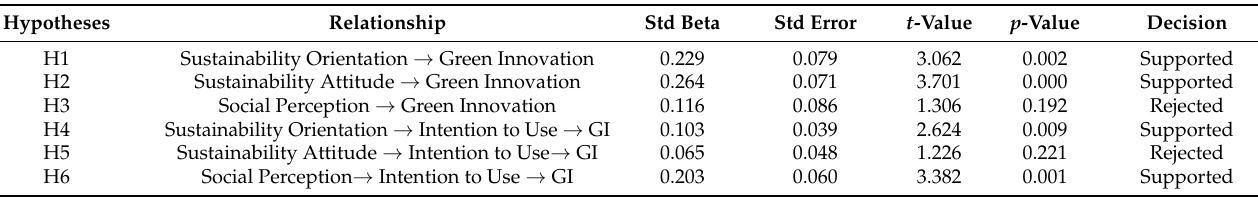
Table 7. Result of direct and indirect effect